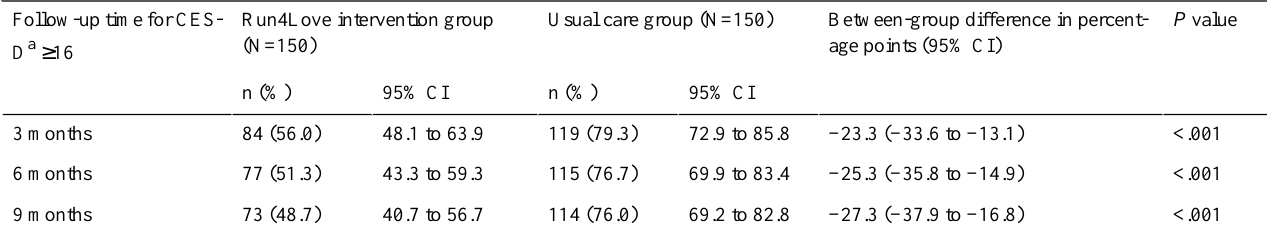
Table 4. Effects of the intervention on exploratory